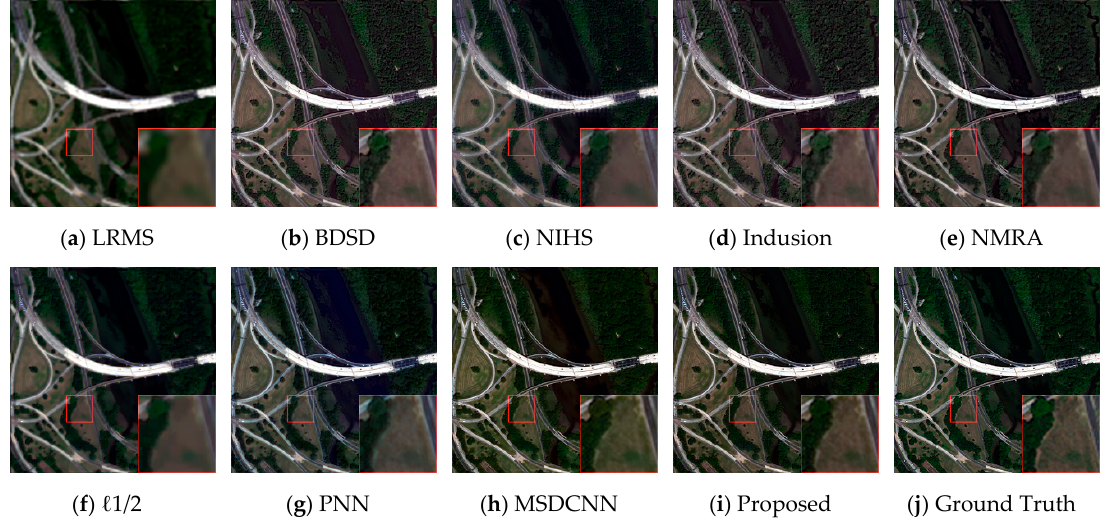
Figure 6. Results of the reduced scale experiment on an area extracted from a WorldView-2 image. ( a ) LRMS; ( b ) BDSD; ( c ) NIHS; ( d ) Indusion; ( e ) NMRA; ( f ) ℓ 1/2; ( g ) PNN; ( h ) MSDCNN; ( i ) Proposed; ( j ) Ground Truth.